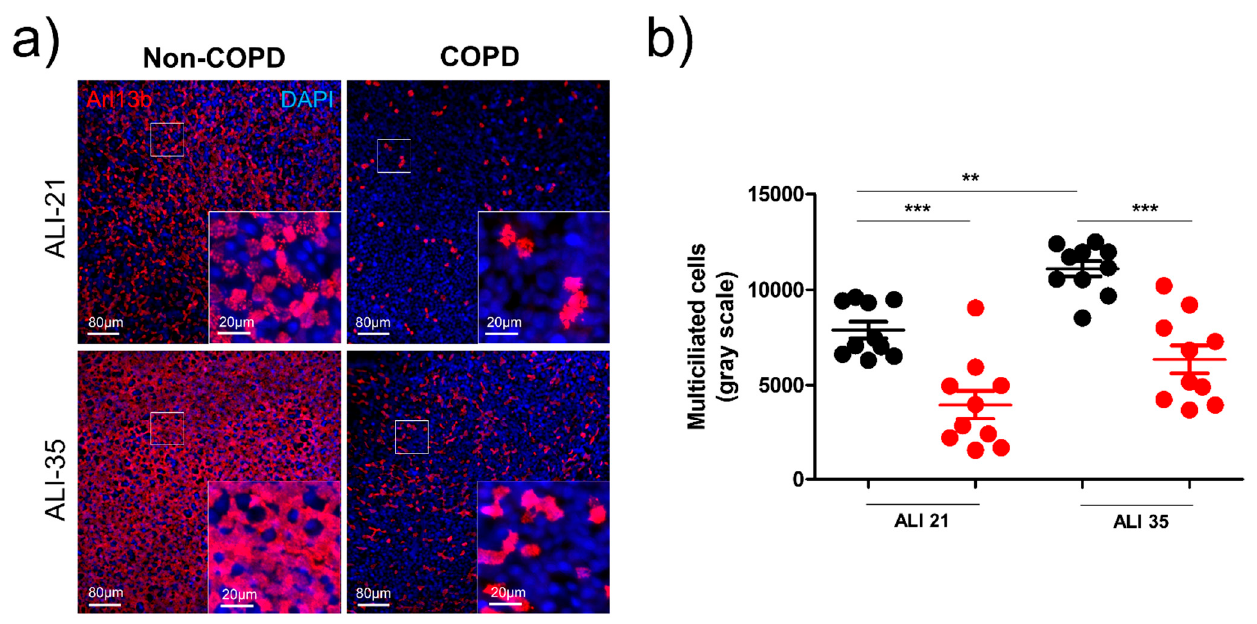
Figure 2. Multiciliated cell generation is decreased in COPD patients. ( a ) Examples of micrographs taken from AEC cultures from non-COPD and COPD patients at ALI-21 and ALI-35 showing motile cilia (Arl13b, red). Nuclei are stained in blue (DAPI). ( b ) Dot plot (mean +/ − SD) represents the mean grey values of cilia-associated fluorescence at ALI-21 and ALI-35 in non-COPD AEC-derived ALI cultures (black, n = 10) and COPD AEC-derived ALI cultures (red, n = 10). ** p < 0.01, *** p < 0.001 non-COPD vs. COPD.